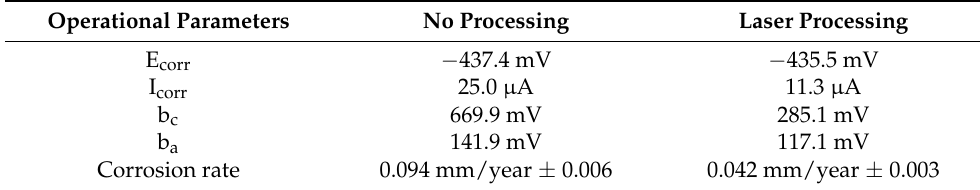
Table 4. Corrosion test parameters and results.